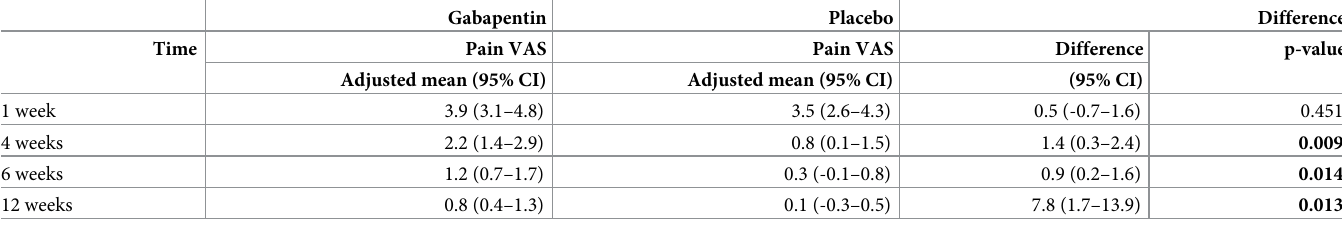
Table 3. Average herpes zoster pain score at week-1, -4, -6, and -12 in the two groups. Gabapentin Placebo